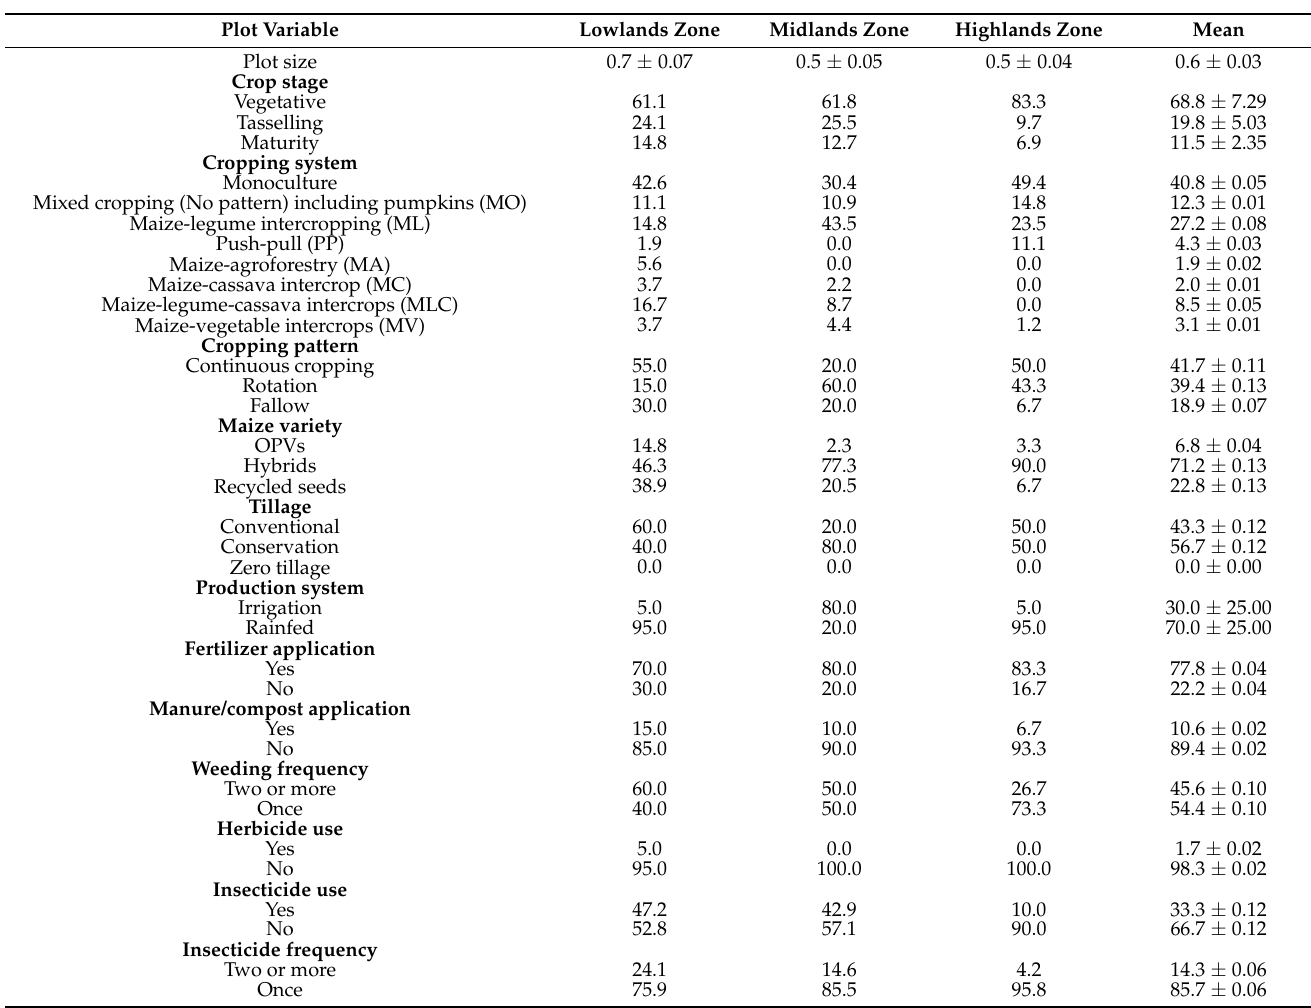
Table 2. Maize field characteristics and crop management practices employed by smallholder farmers interviewed during the survey for fall armyworm infestation and damage in three agro-ecological zones of Kenya in